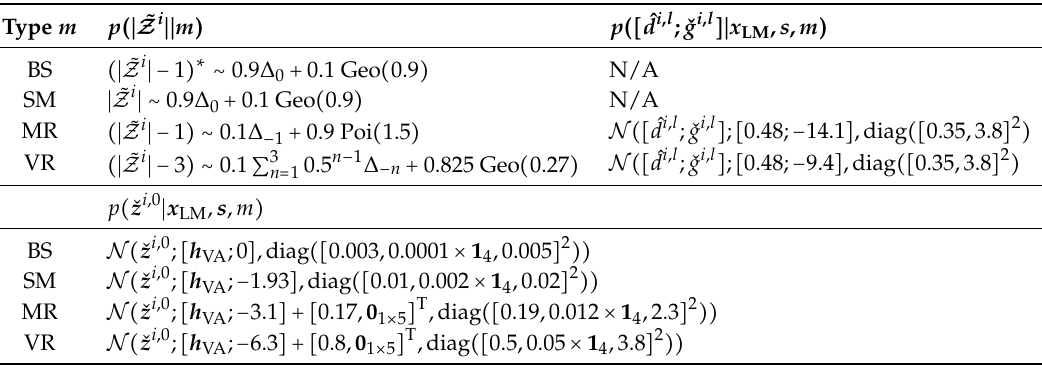
Table 3. Likelihood function for 5G SLAM for different types of